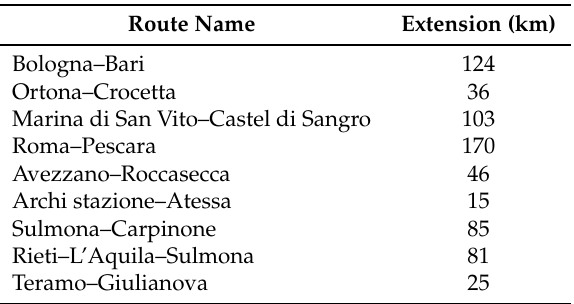
Table 12. The railway lines of